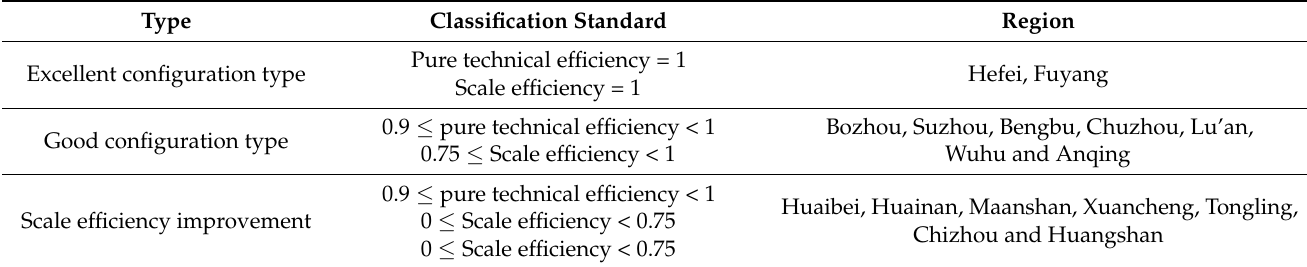
Table 8. Regional classification according to allocation